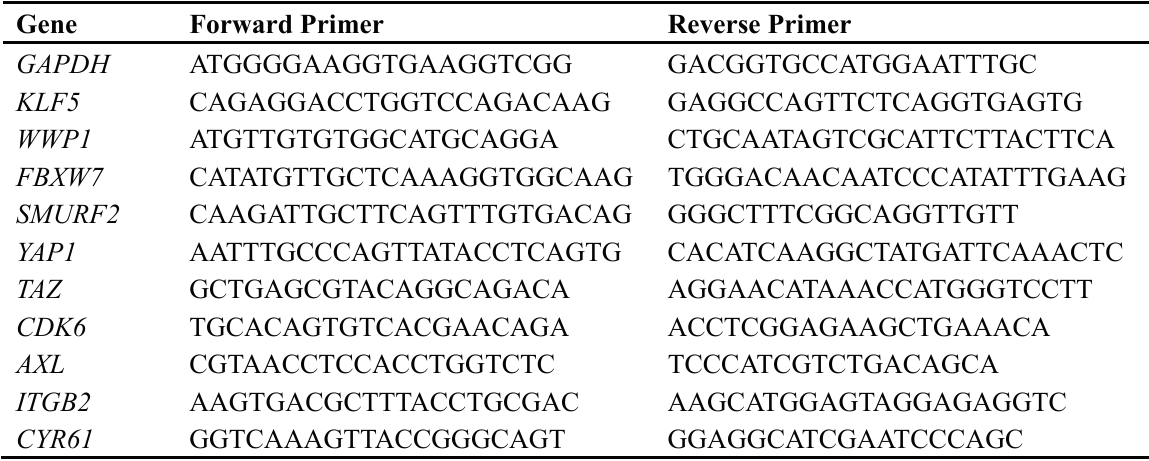
Table 1. Primer sequences used in real-time